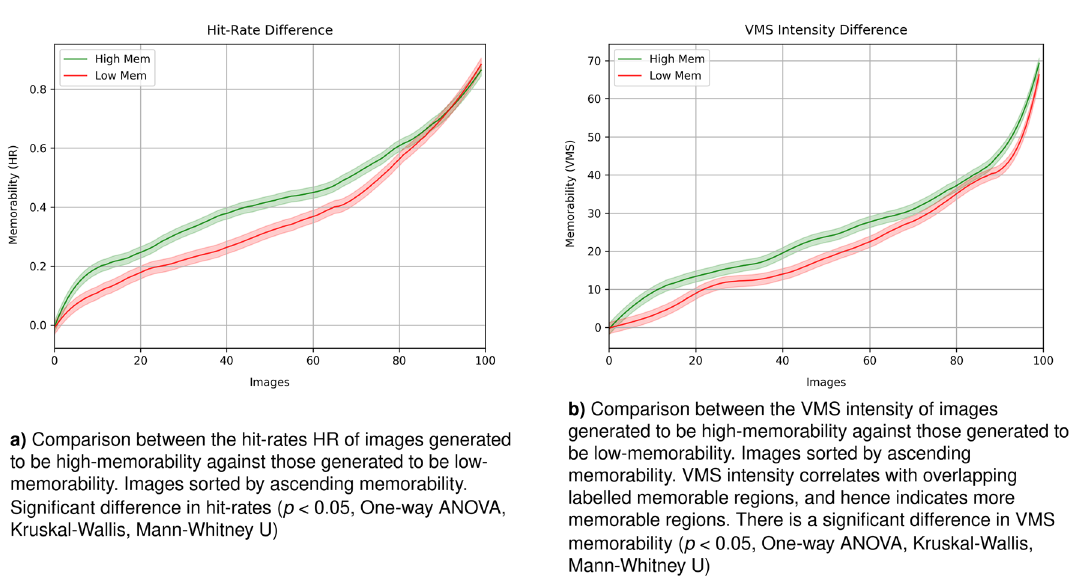
Figure 7. Difference in memorability (HR and VMS Intensity) for generated image populations. Degree 3 polynomial fitted for